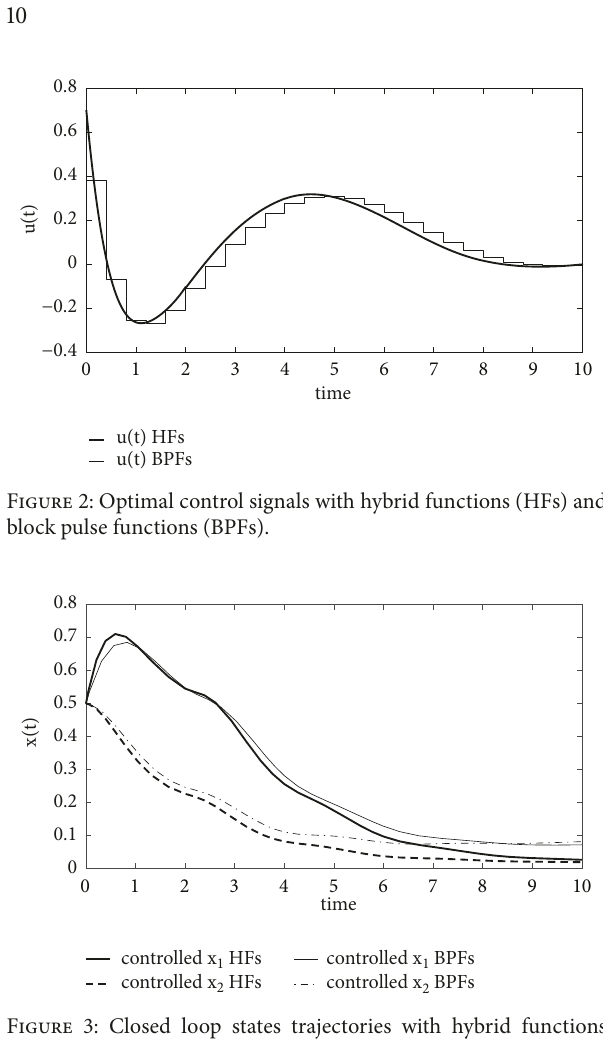
Figure 3: Closed loop states trajectories with hybrid functions (HFs) and block pulse functions (BPFs).